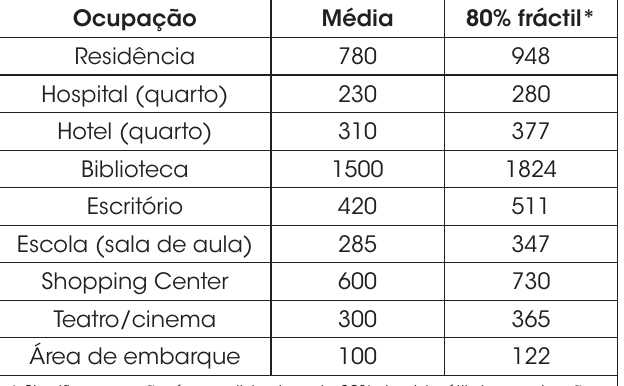
Carga de incêndio específica em MJ/m 2 (EC1, 2002)